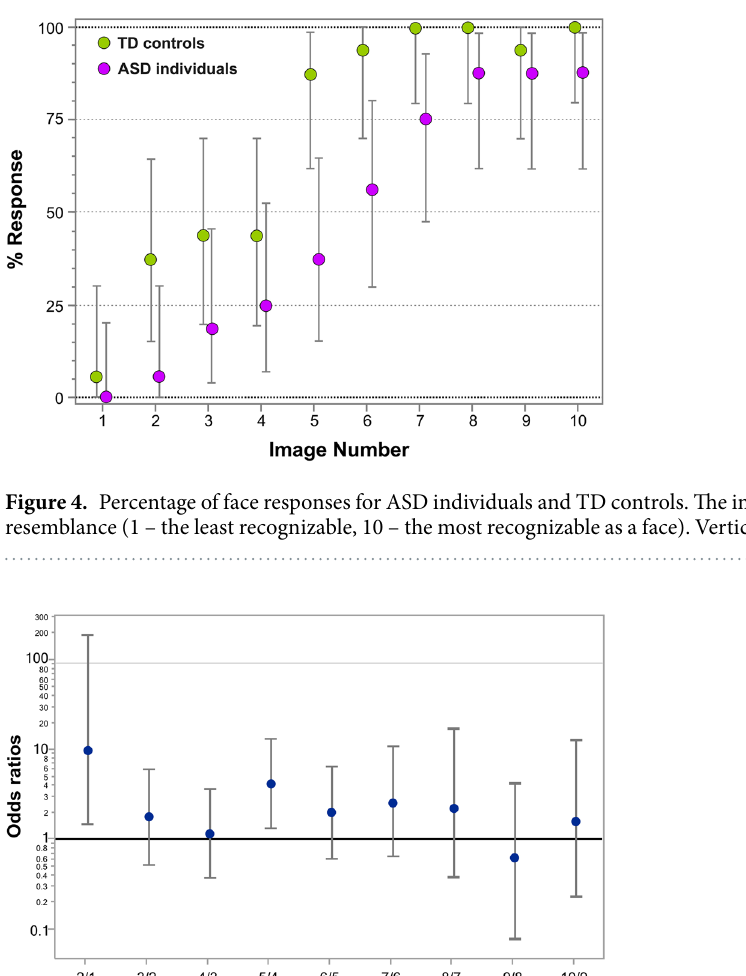
Figure 4 represents the percentage of face responses for each Face-n-Food image for ASD individuals and TD controls. As seen from this figure, individuals with ASD much later reported seeing a face and gave on overall much fewer face responses. As indicated by multiple stepwise nominal logistic regression analysis, the effect of group (TD vs. ASD) is significant ( χ 2 (1) = 24.9, p < 0.0001). For the first five images, ASD individuals provided far less than 50% of face responses, whereas TD group gave almost 50% face responses already from the third image. Starting from the images 5–6, controls very fast reached the ceiling level of performance. By contrast, ASD individuals much later than controls attained the maximal number of face responses for their group, and still gave only 87.7% face responses even with the most resembling face image number 10. Although face recognition level of ASD individuals is much lower, there is no significant interaction between group and image number ( χ 2 (9) = 6.77, p = 0.661, n.s.): the spontaneous face recognition is uniformly shifted down in ASD individuals as compared to TD controls. Figure 5 represents odds ratios for all consecutive pairs of Face-n-Food images independent of group. The leaps in face recognition occurred from the image 1 to 2 with an odds ratio of 6.07 (95% CI, confidence inter- val, 0.005 to 0.658; p < 0.01) and from the image 4 to image 5 with an odds ratio 6.24 (95% CI, 0.075 to 0.742; p < 0.01). The odds ratios for all other pairs (3/2, 4/3, 6/5, 7/6, 8/7, 9/8, and 10/9) are not significantly greater than 1 that indicates the lack of substantial increase in face recognition. As shown by the likelihood ratio analysis, in TD controls as compared to ASD individuals, the odds ratio to give face response to each Face-n-Food image in the set is 6.38 (95% CI, 3.21 to 13.6; p < 0.0001). In ASD individuals, no correlation was found between their performance on the Face-n-Food task (face response rate) and the general IQ scores (Spearman’s rho = 0.239, p = 0.37, n.s., two-tailed; Fig. 6). This indicates that the impaired performance on the Face-n-Food task in ASD individuals stems from the face tuning deficits rather than from general cognitive disabilities that may affect task performance.